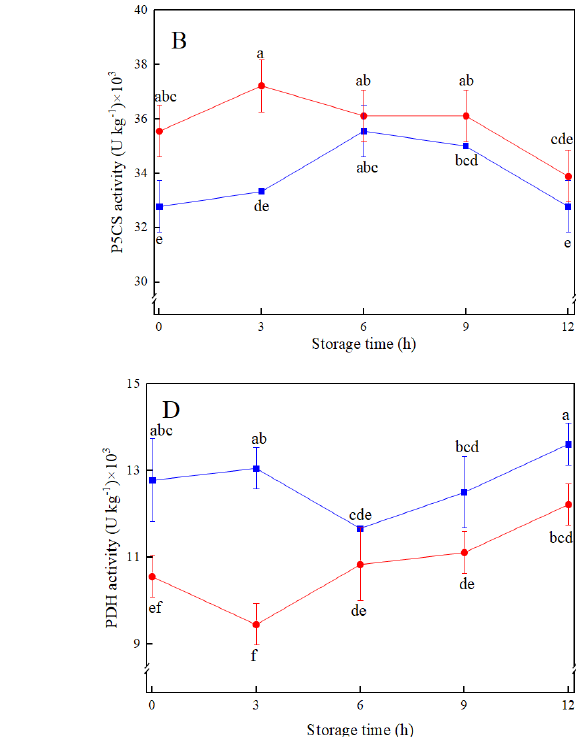
Figure 3. Effects of H 2 S treatment on GABA content ( A ) and GAD activity ( B ) of fresh-cut peaches during storage. Data are presented as mean ± standard errors of triplicate samples. Different letters indicate statistically significant ( p < 0.05) differences.